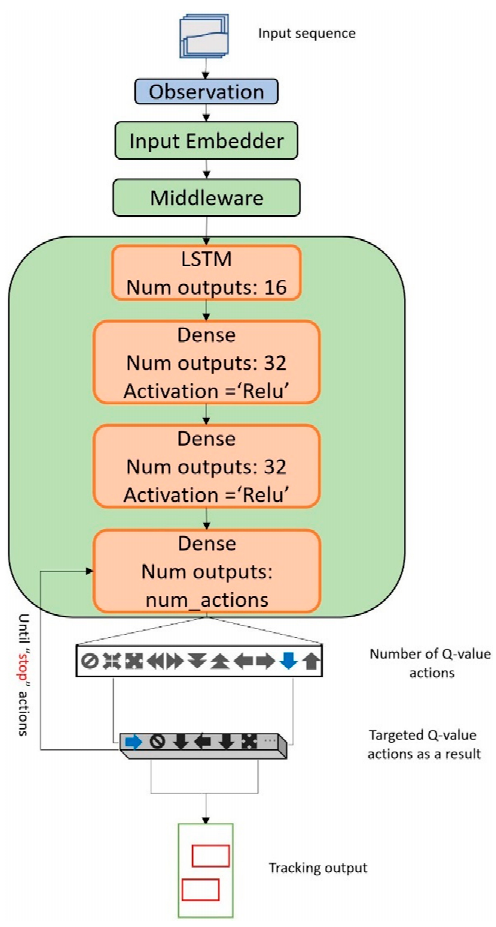
Figure 5. The implementation of the deep Q-neural network agent model initiation with the tracking process by calculating the intersection over union of two predicted bounding boxes from targeted action values.